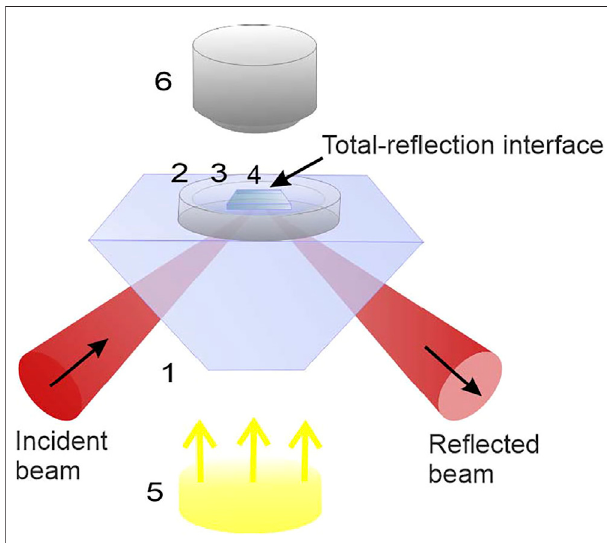
FIGURE 8 | Experimental arrangement for the vertical spin detection: (1) glasscutrectangularprism(refractionindexequals1.52);(2)2-mm-heightring cuvette; (3) water layer; (4) crystalline plate; (5) white-light illuminating source; (6) CCD